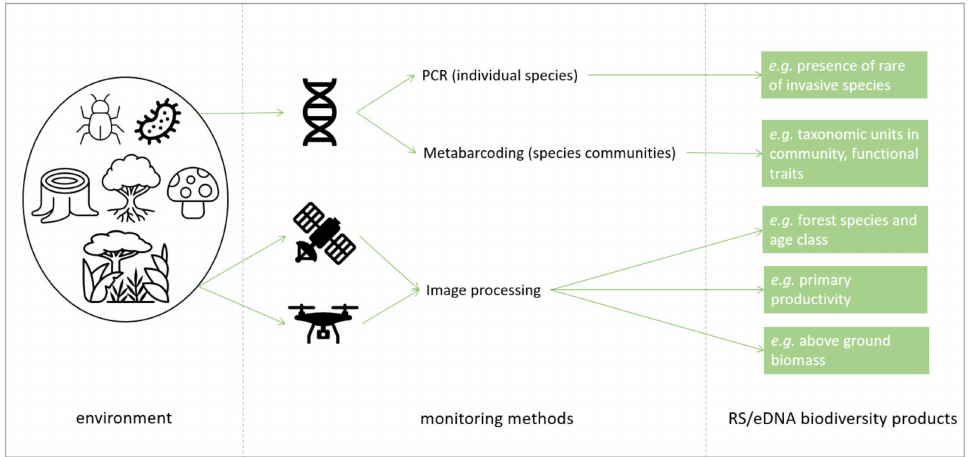
Figure 3. From species and landscapes, different kinds of biological information can be extracted. From environmental DNA, through PCR or metabarcoding sequencing, information about species can be obtained. Remote sensing biodiversity products are obtained from imagery or scans, e.g., taken by satellites or